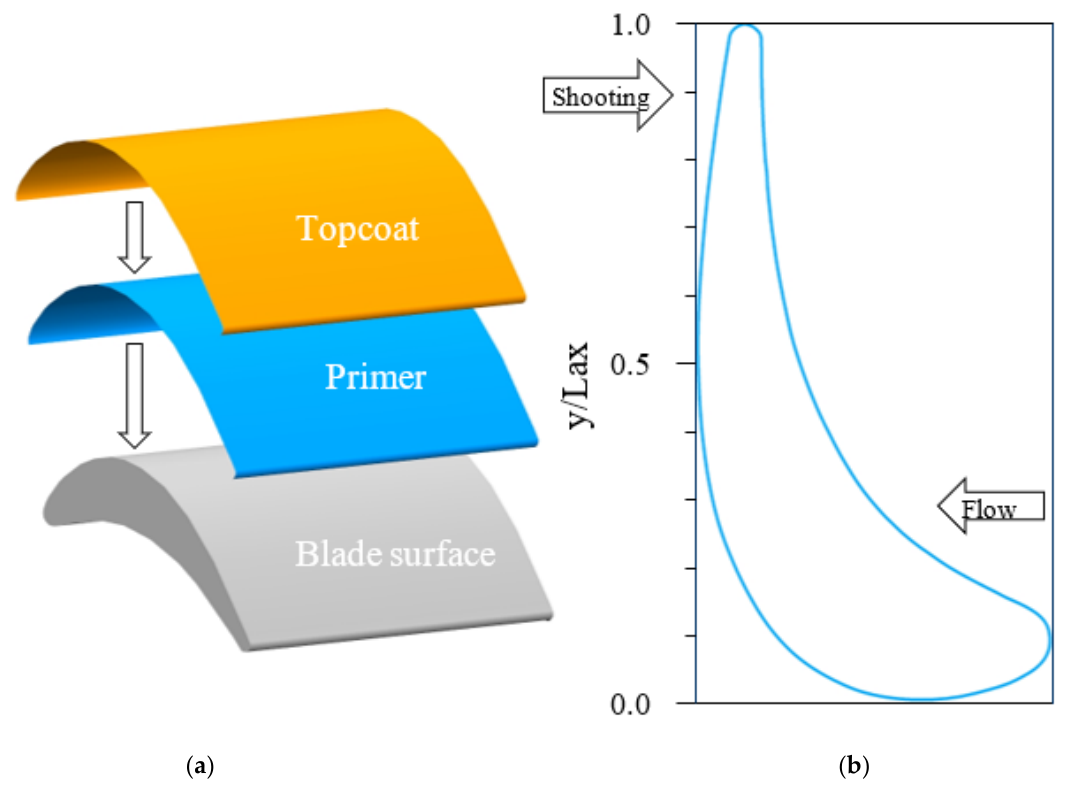
5 of 18 Table 2. Design parameters of transonic VKI-RG turbine. Parameters